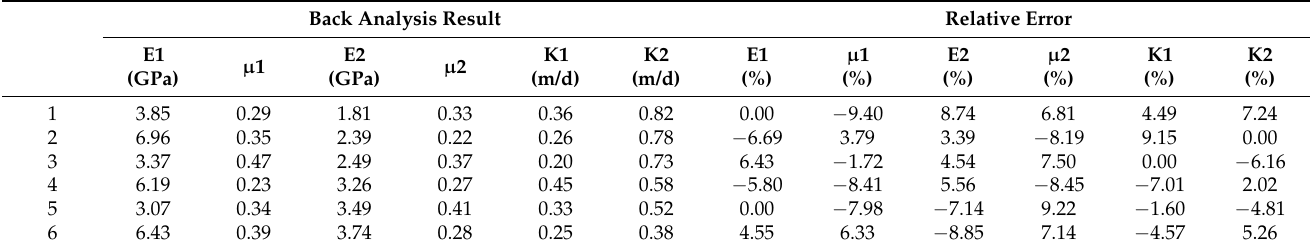
Table 4. Parameters of surrounding rock of uniform testing scheme analysis results.